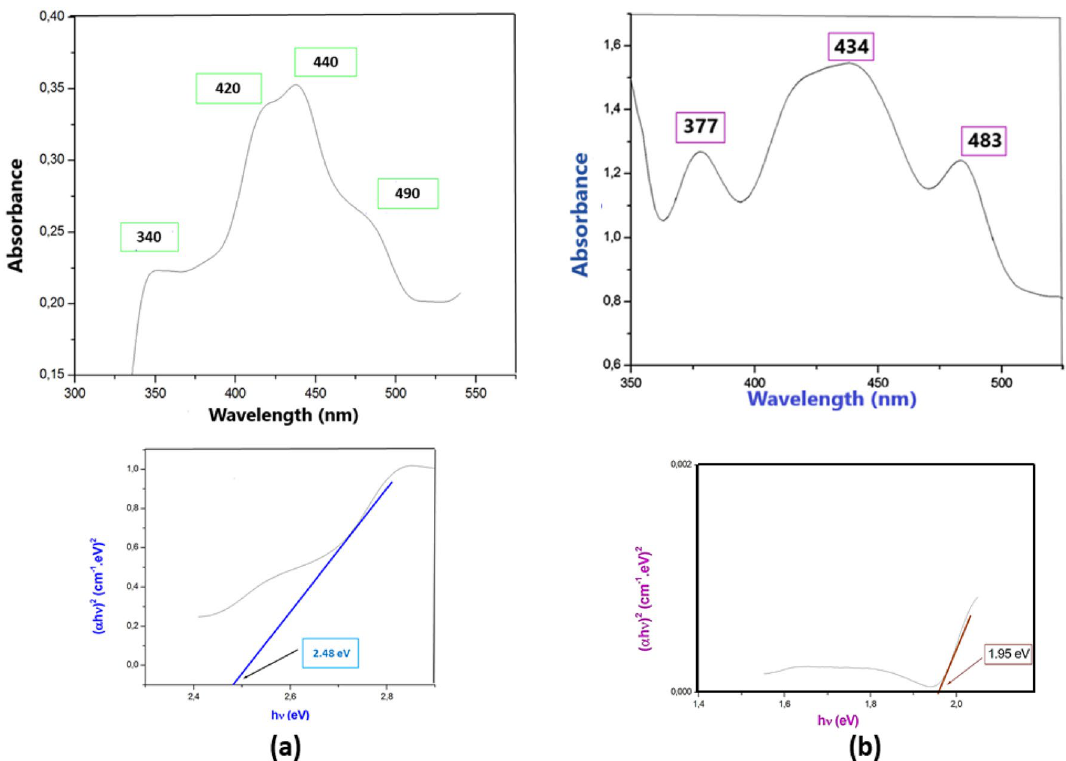
Figure 8. Solid state UV–Vis spectrum and TAUC representation of ( a ) {[Co(SCN) 4 ] (C 8 H 12 N) 3 }·Cl and ( b ) {[Co(SCN)